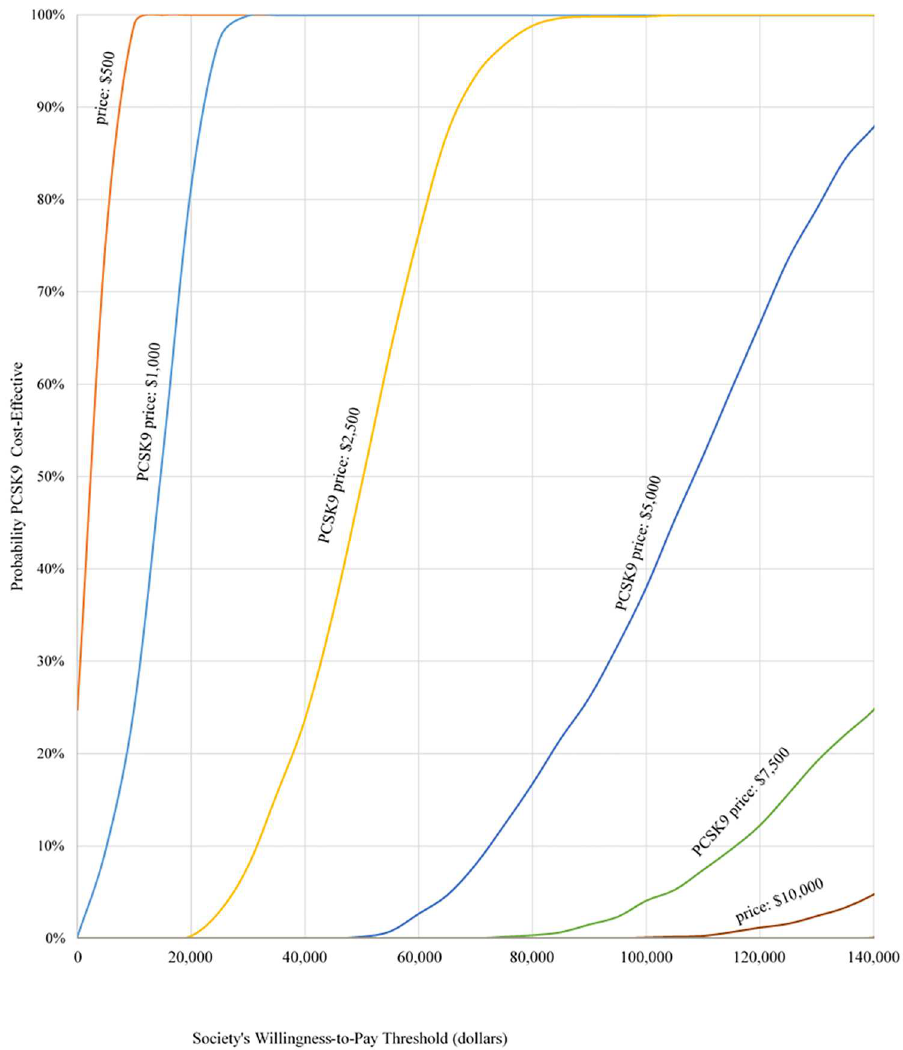
Fig 2. Acceptability curve from health